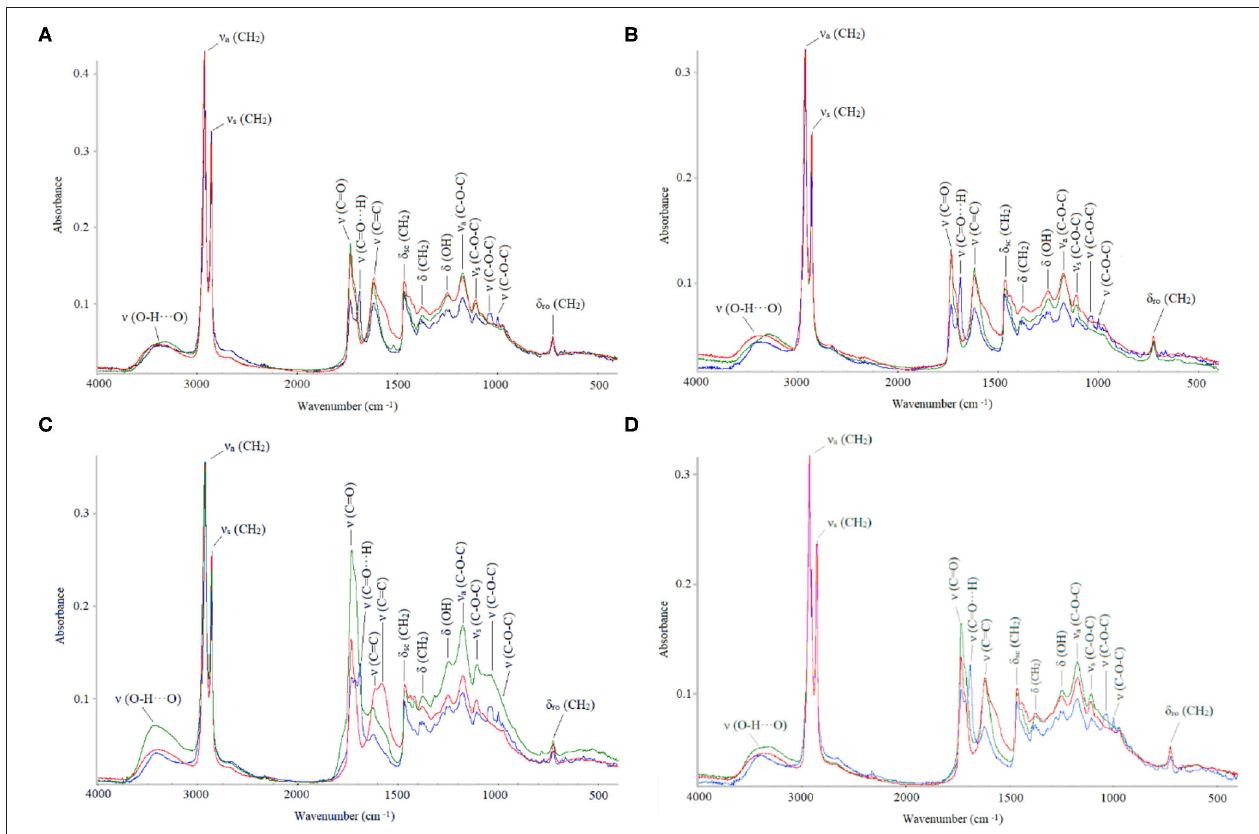
FIGURE 3 | Fourier transform infrared (FTIR) absorbance values (in cm − 1 ): natural (blue), dewaxed (green), and combined treatment (red). (A) Adaxial young, (B) abaxial young, (C) adaxial old, and (D) abaxial old cuticles.